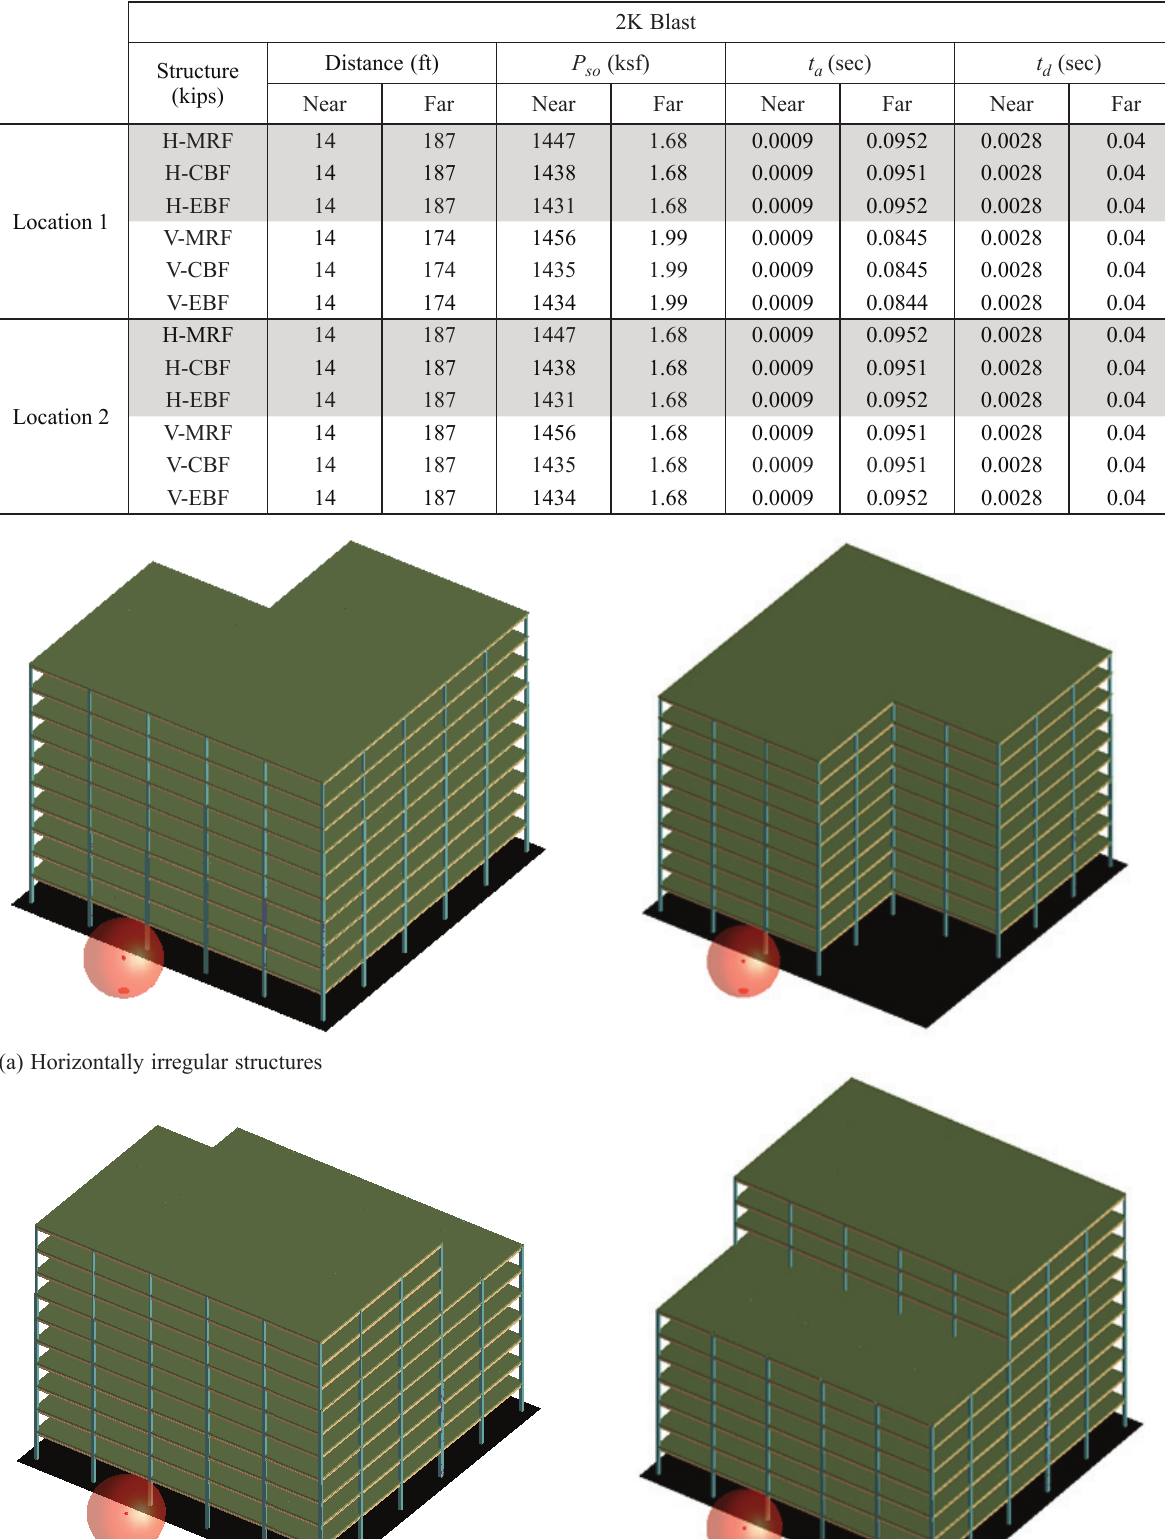
Table 7. Blast parameters